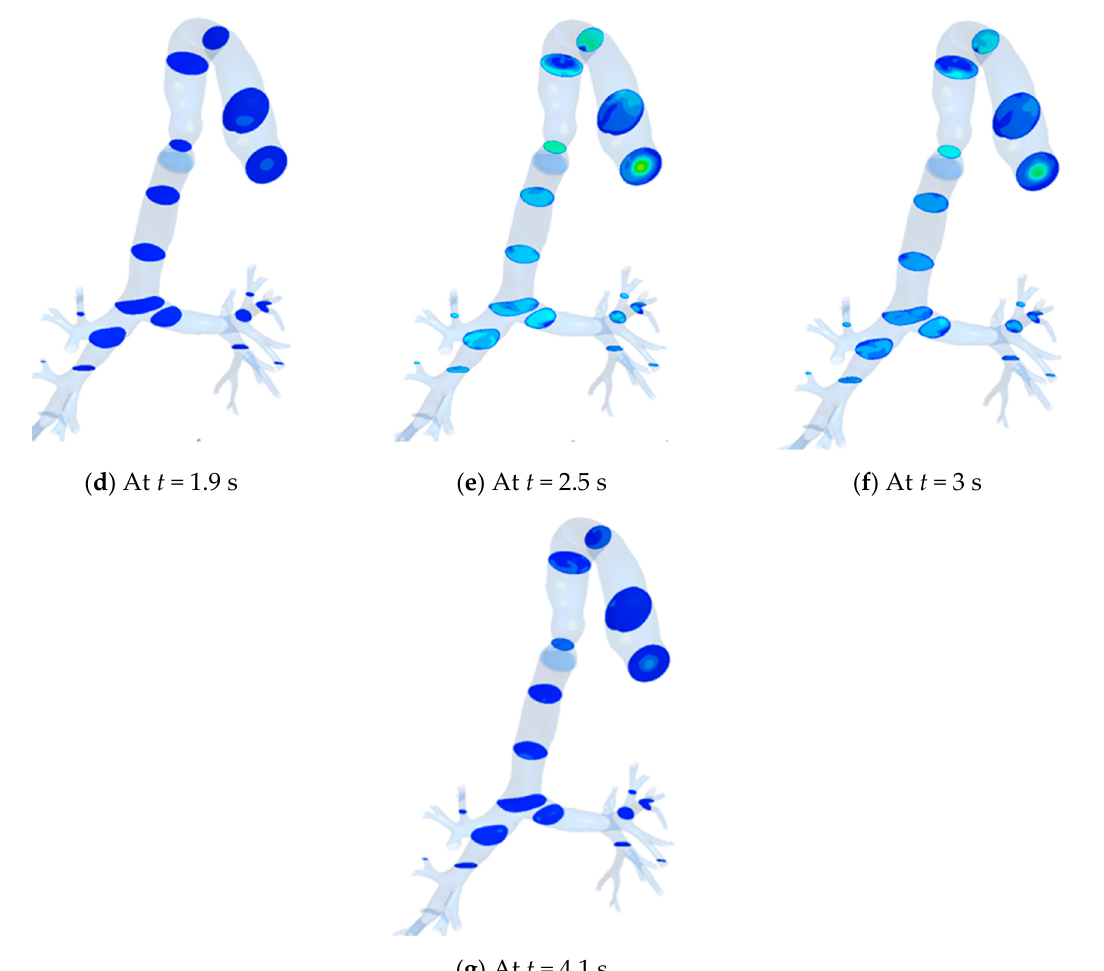
Figure 12. Velocity contour at different planes with time. ( a ) At t = 0.5 s; ( b ) At t = 1.0 s; ( c ) At t = 1.5 s; ( d ) At t = 1.9 s; ( e ) At t = 2.5 s; ( f ) At t = 3 s; ( g ) At t = 4.1